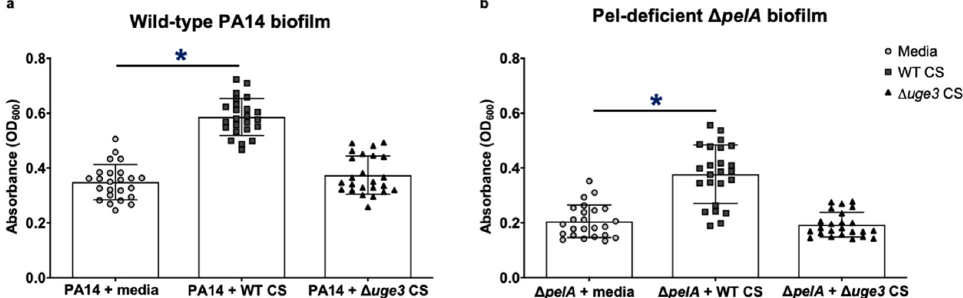
Figure 4. A. fumigatus -secreted products increase the formation of P. aeruginosa -adherent biofilms. Crystal violet quantification of adherent biofilm biomass by ( a ) wild-type P. aeruginosa (PA14) and